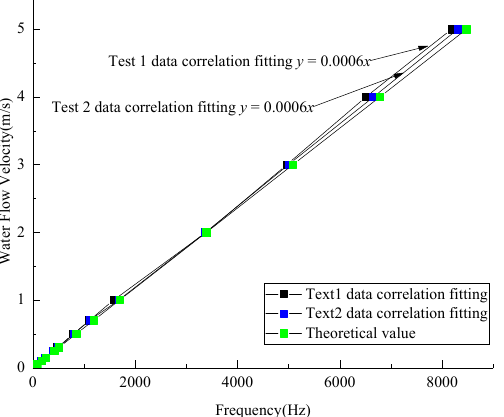
Figure 23. Analysis of the experimental frequency and the theoretical frequency.